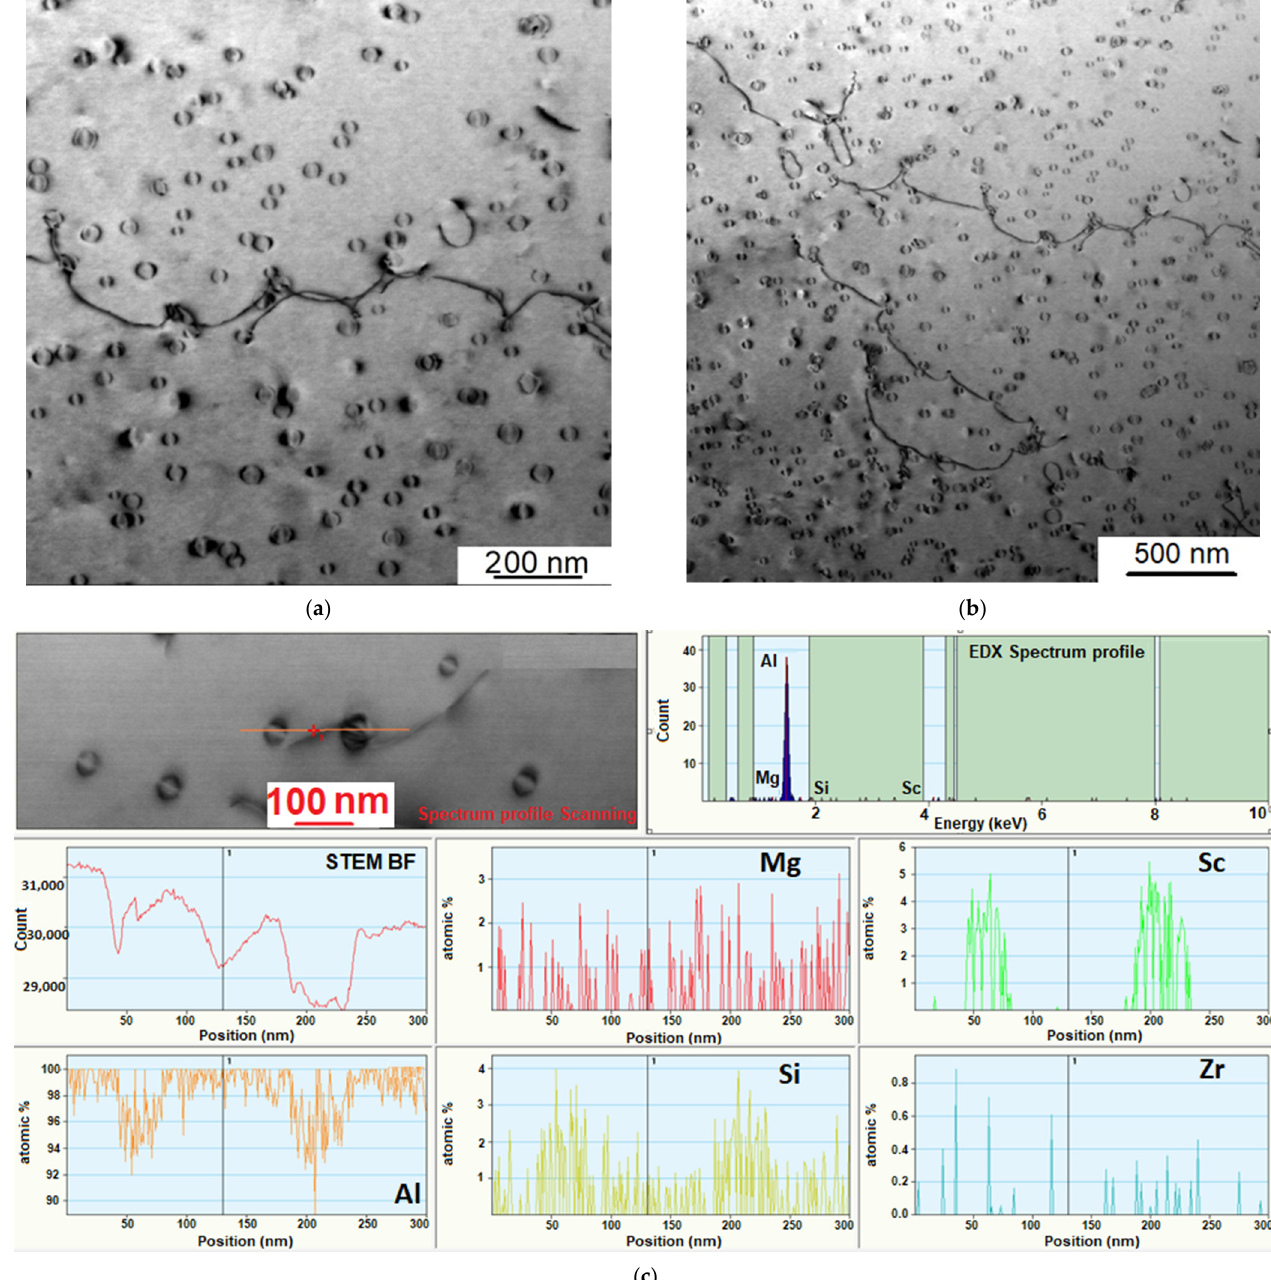
Figure 13. ( a , b ) AlSi) 3 ScZr particles with the L1 2 structure, ( c ) EDS profile line